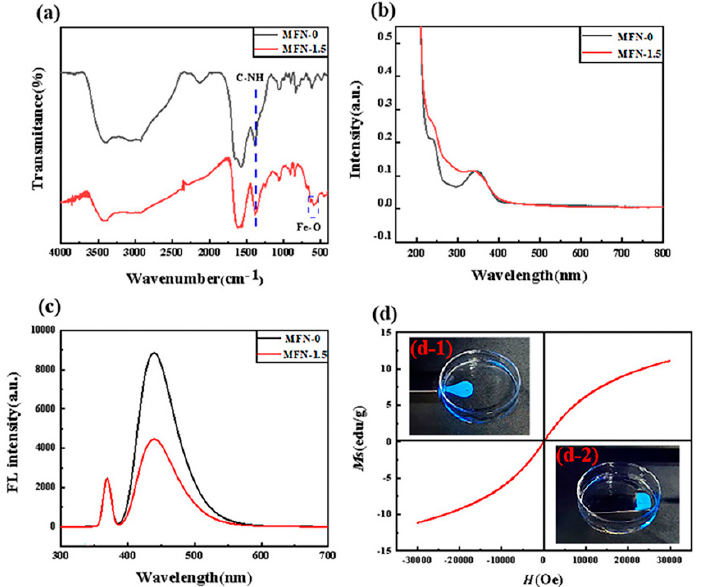
Figure 5. ( a ) FT-IR spectra of MFN-0 and MFN-1.5; ( b ) UV–Vis spectra of MFN-0 and MFN-1.5; ( c ) fluorescence emission spectra of MFN-0 and MFN-1.5; ( d ) magnetization hysteresis loop of MFN-1.5, inserts ( d - 1 ) and ( d - 2 ) state diagrams of MFN-1.5 after being attracted in ultrapure water when the magnet was placed on the left side and directly below the petri dish.